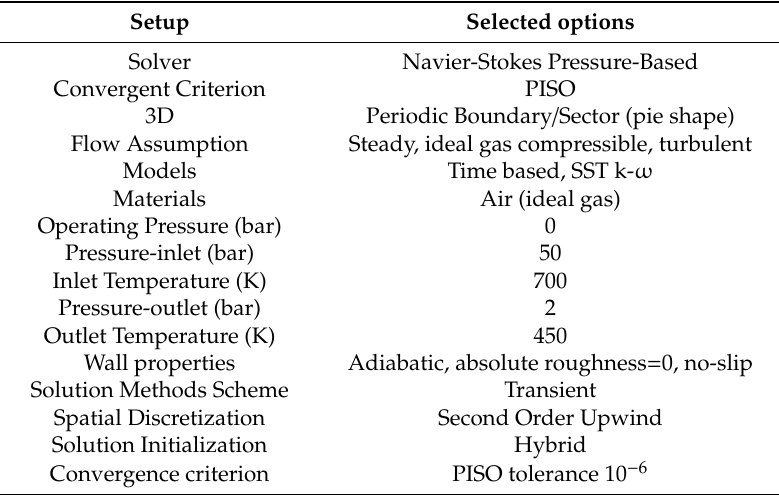
Table 1. CFD model